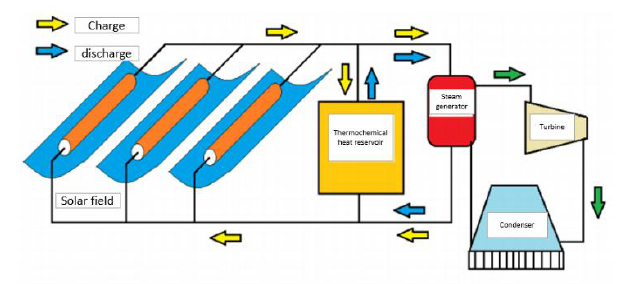
Figure 6. Schematic representation of thermal power plant operation with chemical storage